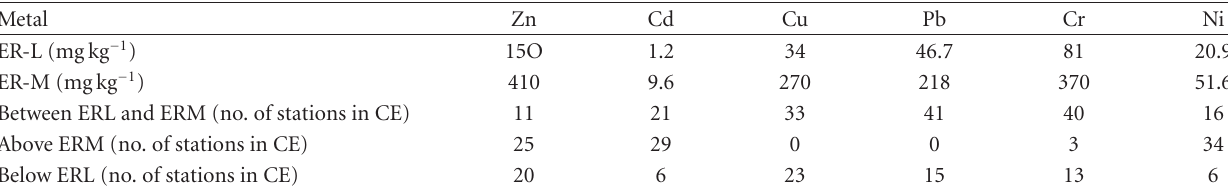
Table 5: Number of samples that had metal concentrations above and below the sediment e ff ects data of ERM and ERL in the Cochin Estuary. ERM and ERL guidelines were from